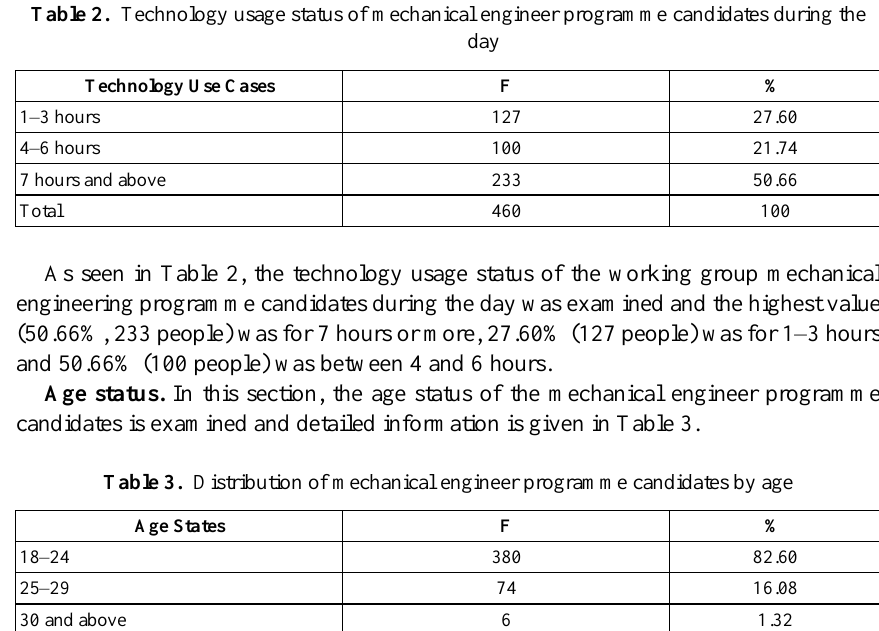
Table 2. Technology usage status of mechanical engineer programme candidates during the